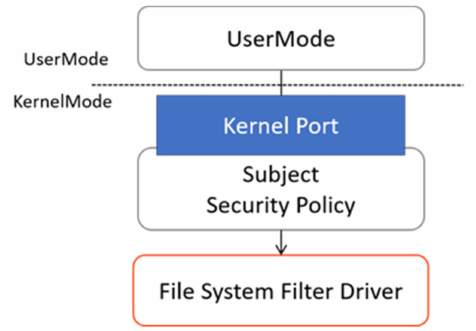
Figure 8. Subject’s policy setting through a kernel